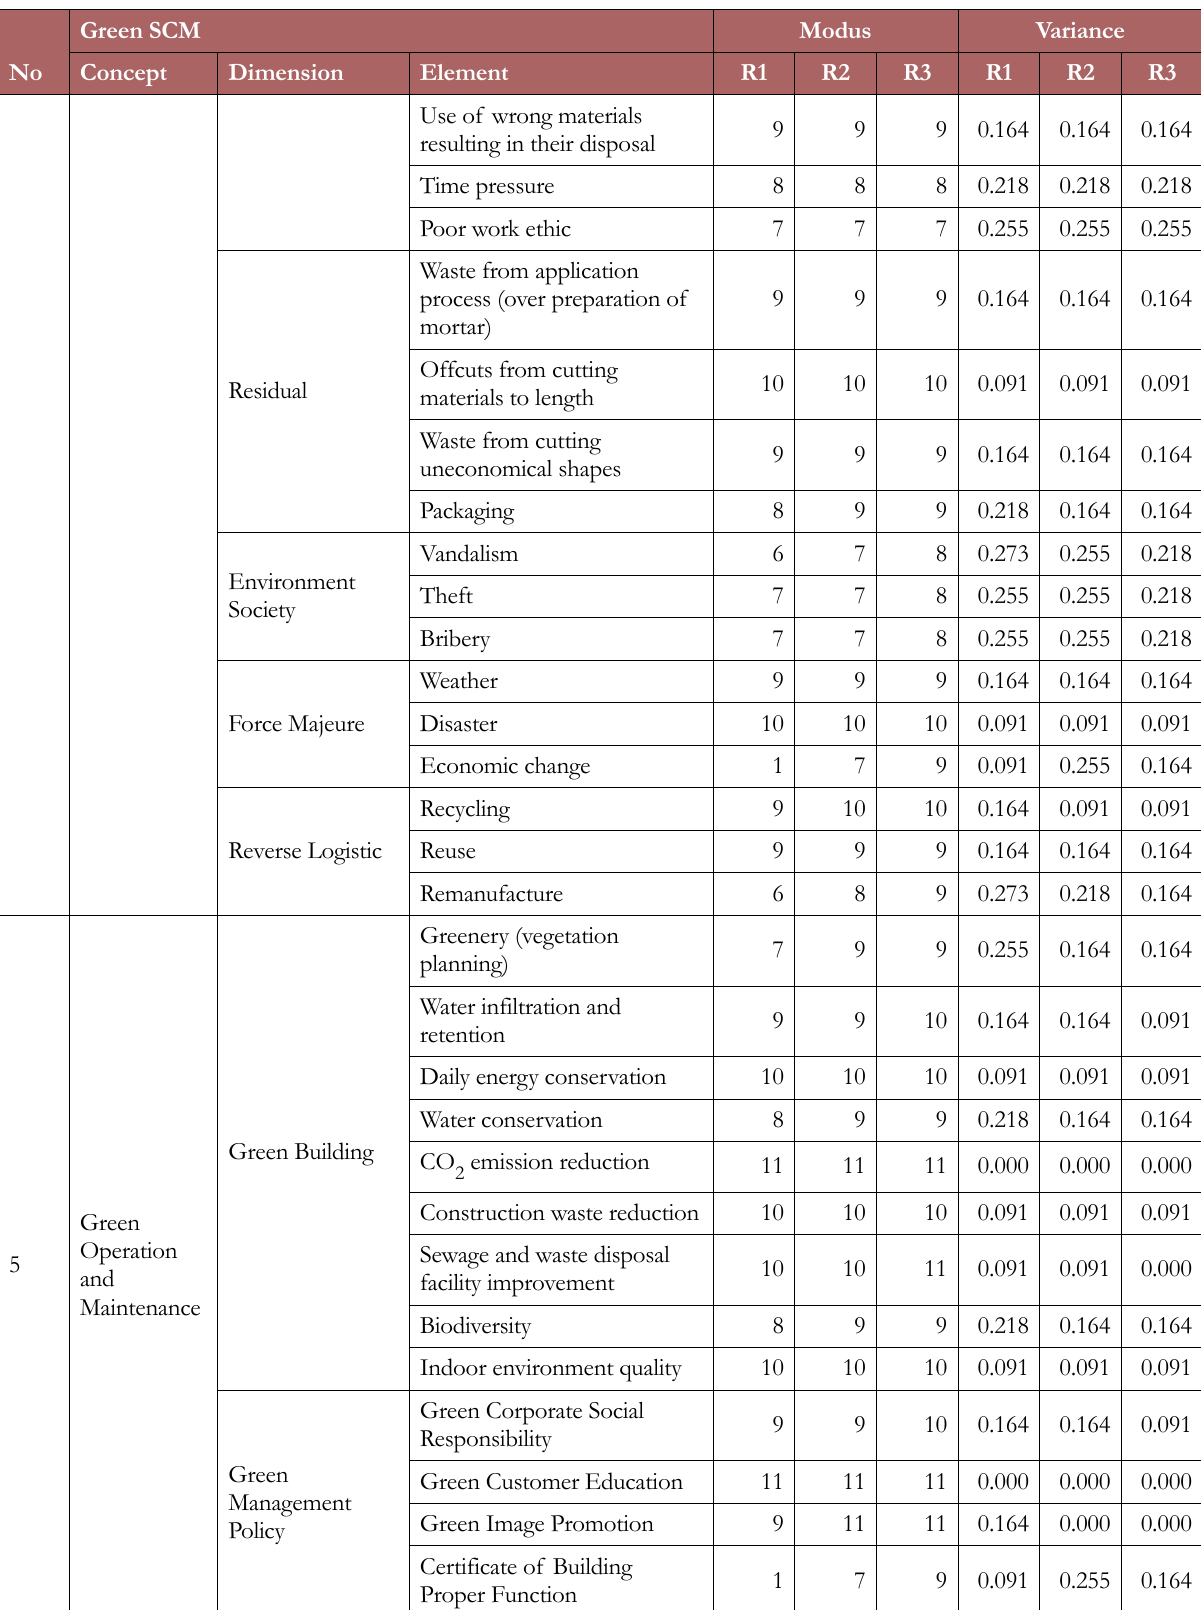
Table 7. Delphi Results for the GSCM Elements in the Construction